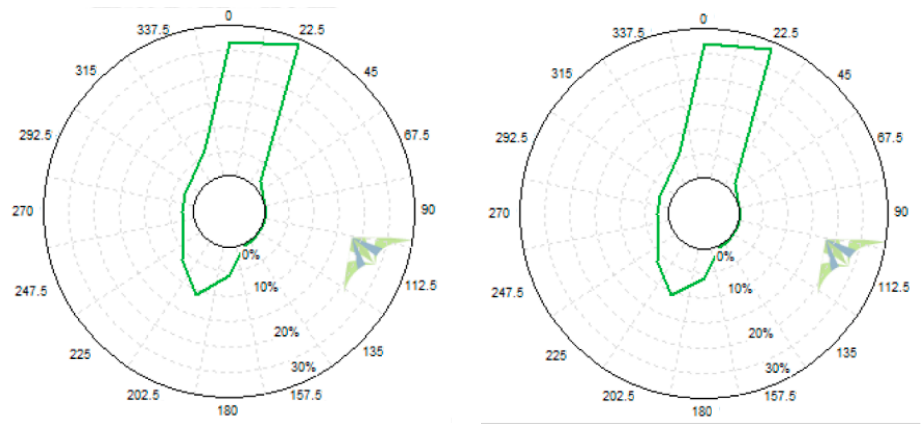
Figure 8. Wind direction at the floating LiDAR device ( left ), and mast ( right ) determined by using MCP with MERRA location 2 data.